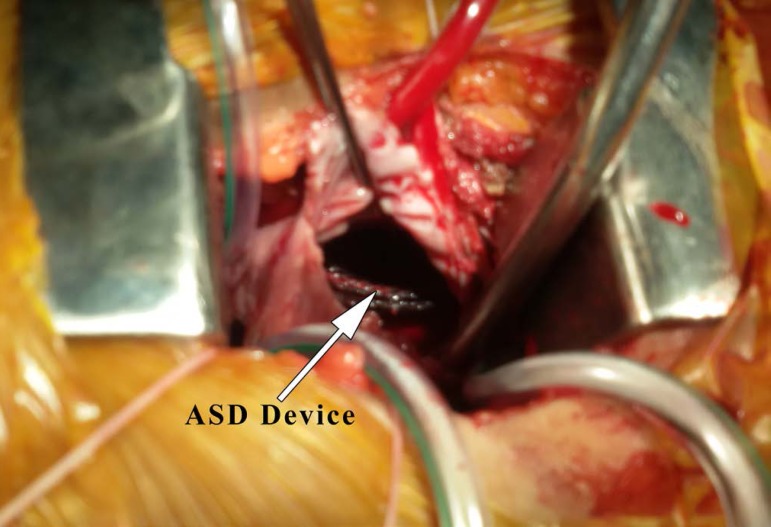
Migrated ASD closure device in right atrium seen preoperatively on
minithoracotomy approach.